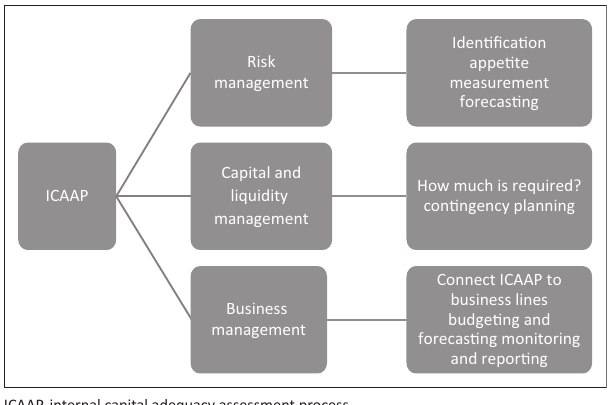
FIGURE 13: The proposed framework for the implementation of an internal capital adequacy assessment